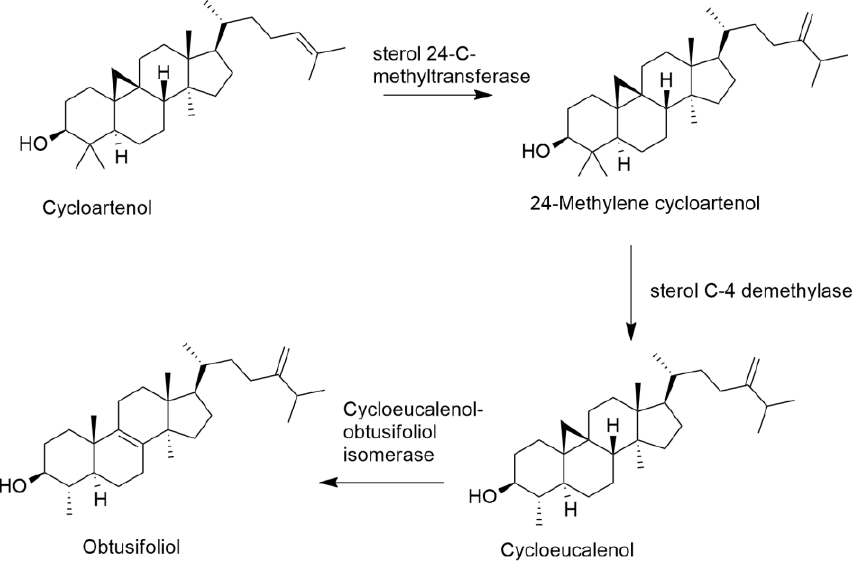
Figure 9. Schematic biosynthesis of obtusifoliol (adapted from [36]).